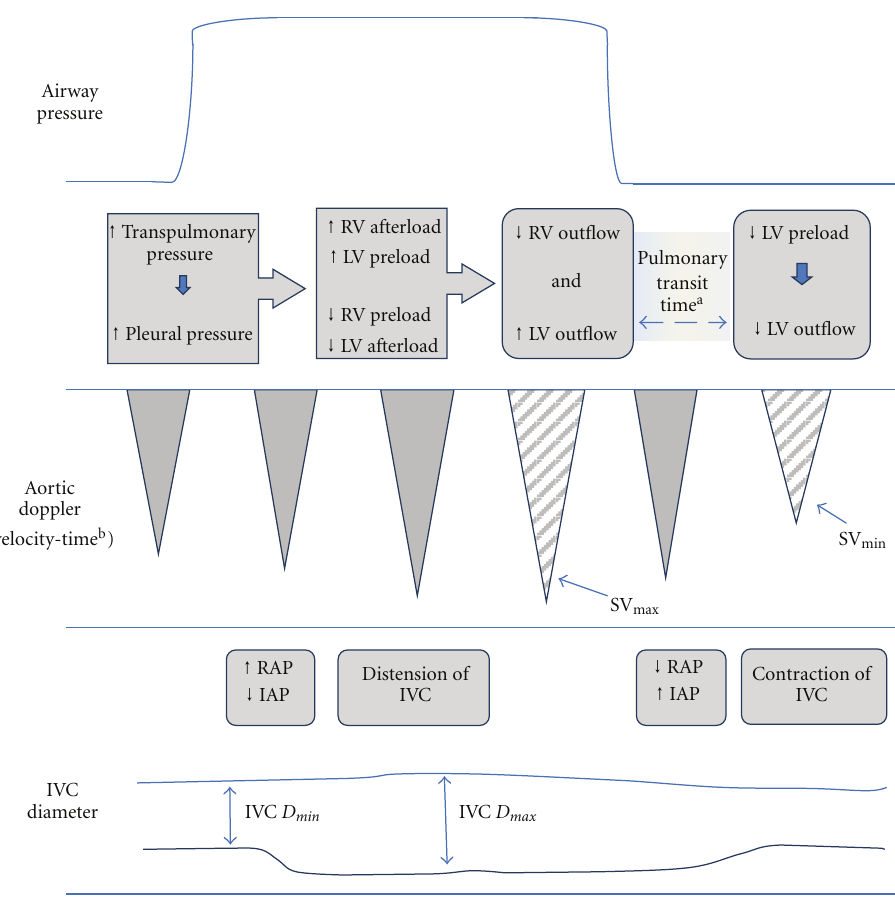
Figure 1: The physiological explanation for the changes in stroke volume and IVC diameter caused by mechanical ventilation. RV right ventricle, LV left ventricle, SV max and SV min maximumand minimum stroke volume, RAP right atrial pressure, IAP intraabdominal pressure, IVC D max and IVC min maximum and minimum inferior vena cava diameter during the cycle. a The pulmonary transit time represents the time taken for blood to travel through the pulmonary circulation. b SV is the product of the velocity-time integral (area under the Doppler signal curve) and the diameter of the vessel at the point the reading was